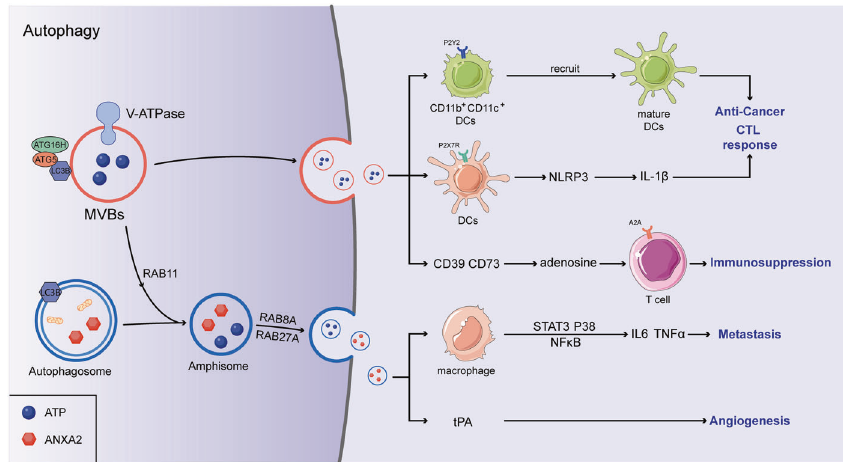
Fig. 1 Autophagy and the release of immune-related EVs. The autophagy-associated complex (ATG5 – ATG16) translocalized to MVBs and dissociated vacuolar proton pumps (V-ATPase) from MVBs, in which the acidi fi cation of the MVBs lumen was inhibited. Ultimately, the secretion of EVs augmented via MVBs – plasma membrane (PM) fusion. In addition, amphisomes were formed by the fusion of autophagosomes and MVBs, which accelerated the EVs release controlled by RAB8A and RAB27A. Immunoregulatory factors including ANXA2 and ATP were contained in EVs, ANXA2 can induce an increased secretion of TNF α and IL6 by activating the STAT3, p38, and NF- κ B pathways in macrophages. In addition, ANXA2 promotes tPA-dependent angiogenesis. ATP can promote the differentiation of CD11b + CD11c + Ly6C high cells into mature DCs by binding with purinergic receptor P2Y2, and upregulate the IL-1 β production through NLRP3 in fl ammasome, ultimately stimulating the activation of anti-tumor CTL responses. However, adenosine can be converted from ATP hydrolyzed by CD39 and CD73, further inhibiting T-cell activation through binding with the adenosine A(2 A)